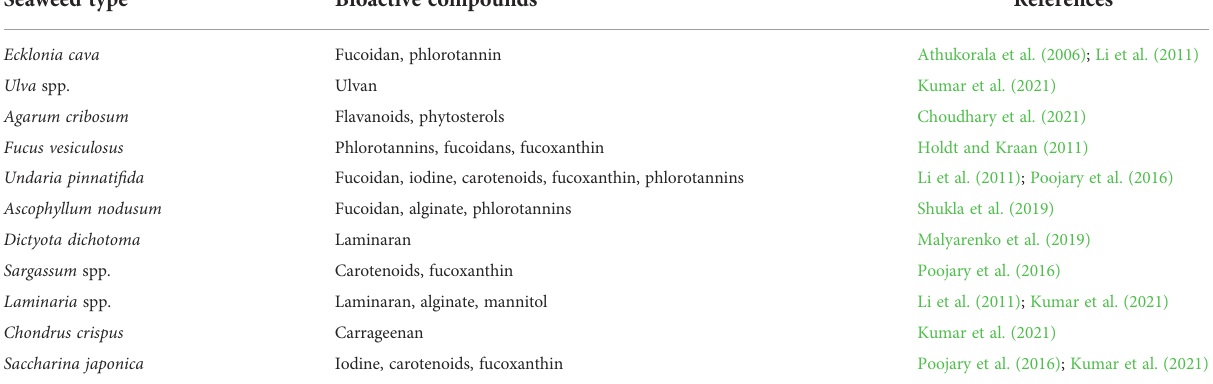
TABLE 3 Bioactive compounds present in various